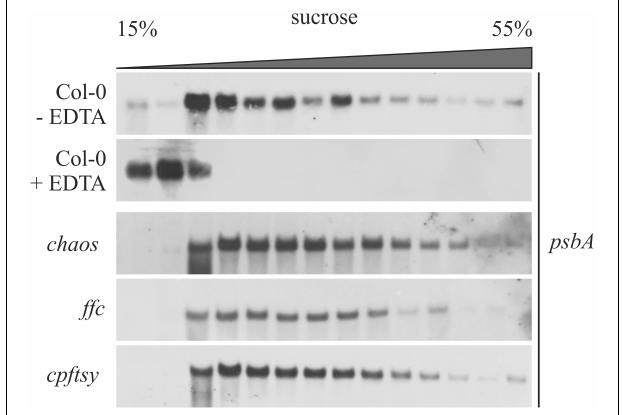
FIGURE 6 | Association of psbA transcript with chloroplast polysomes. Polysomes isolated from wild type (Col-0) and mutant plants at rosette stage were fractionated on a 15–55% sucrose gradient by ultracentrifugation. Subsequently, the gradients were fractionated and the amount of psbA transcript was investigated in each fraction by northern blot analyses using a psbA -specific probe. As a control, polysomes were destroyed using EDTA.